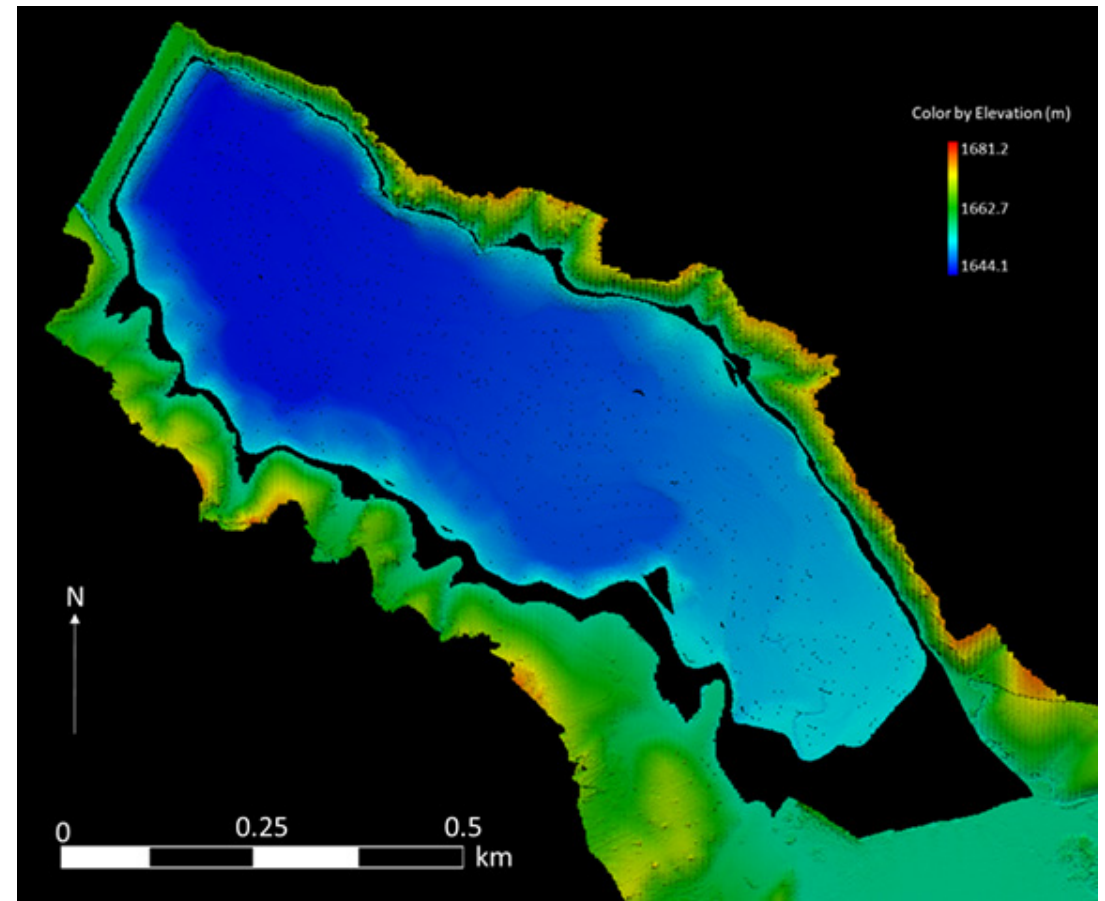
Figure 13. The integrated model produced after knitting together the shoreline model and sonar model. The gap between the datasets could not be collected during the sonar or drone survey.